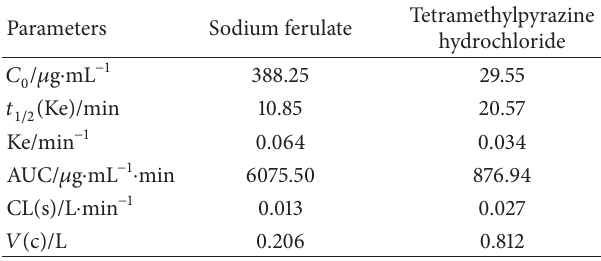
Table6:Pharmacokineticsparametersofsodiumferulateandtetra- methylpyrazine hydrochloride.